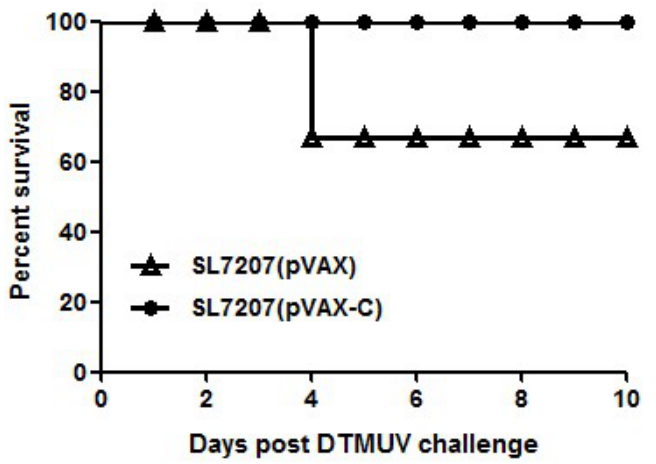
Figure 4. Survival post challenge with lethal doses of virulent DTMUV. The ducks ( n = 10/group) were challenged with 10 4.5 -fold ELD 50 DTMUV at 16 days after the second immunization. The death number of ducks was recorded for consecutive 10 days after virus intravenous injection and graphed by GraphPad Prism